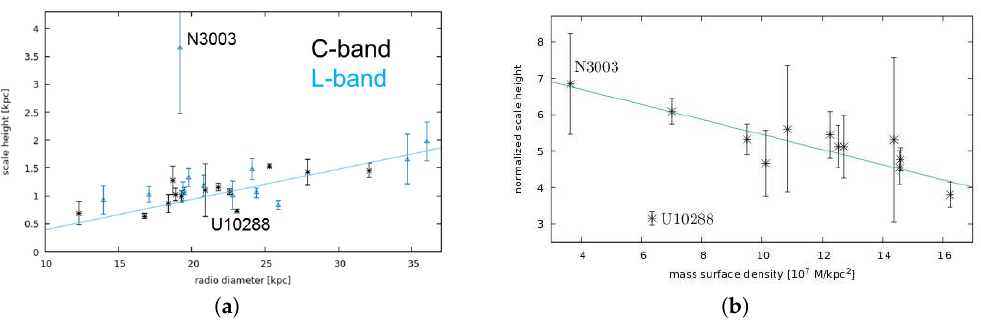
Figure 2. Galaxy-scale height correlations from [27]. ( a ) Scale heights increase with the radio diameter of the galaxy. ( b ) Normalized scale heights decrease with the mass surface density of the underlying disk.